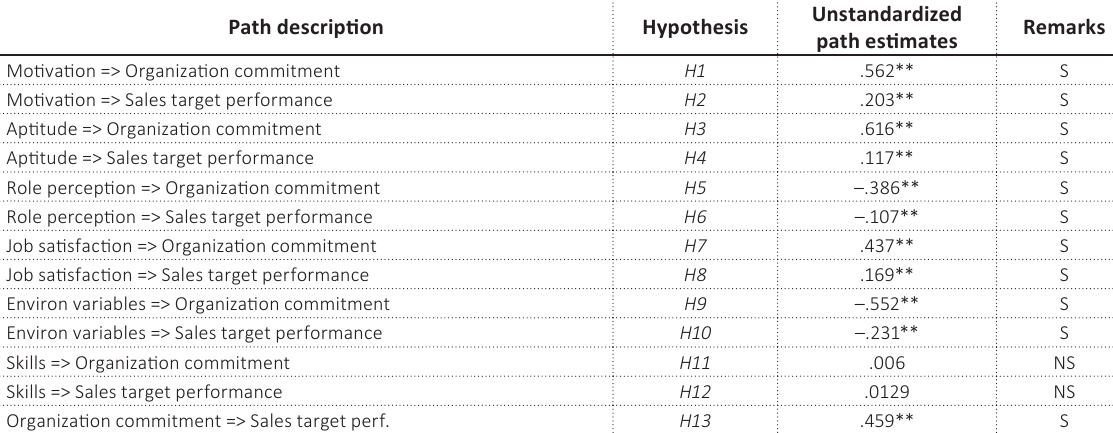
Figure 3. SEM output showing results of hypothesized relationships Table 4. Structural equation modeling